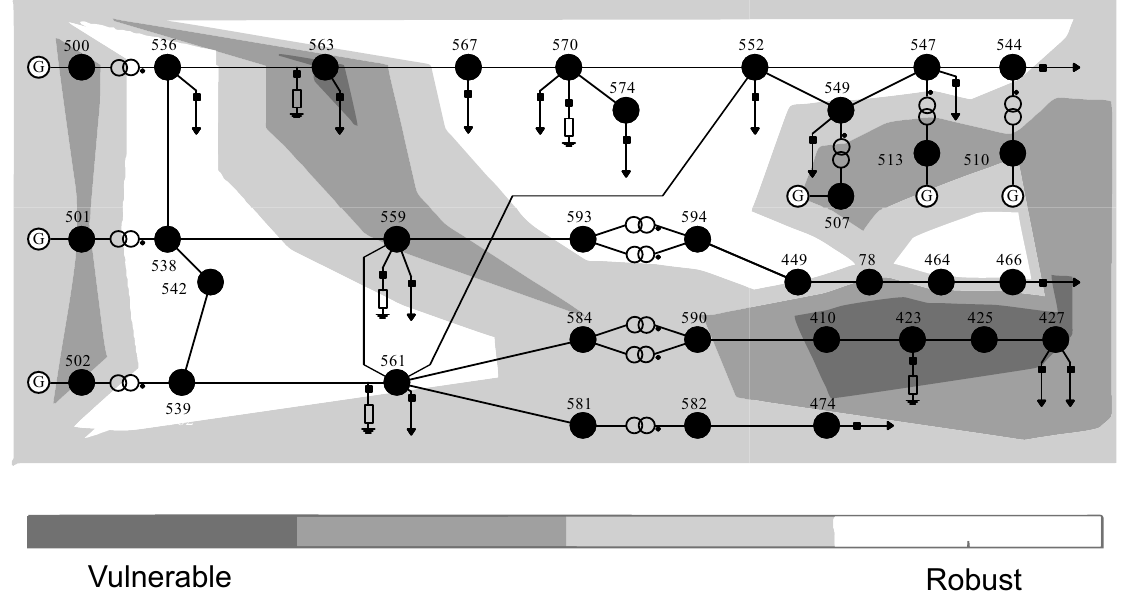
Robustness areas (RA) map for the São Paulo State power grid during restoration—proposed